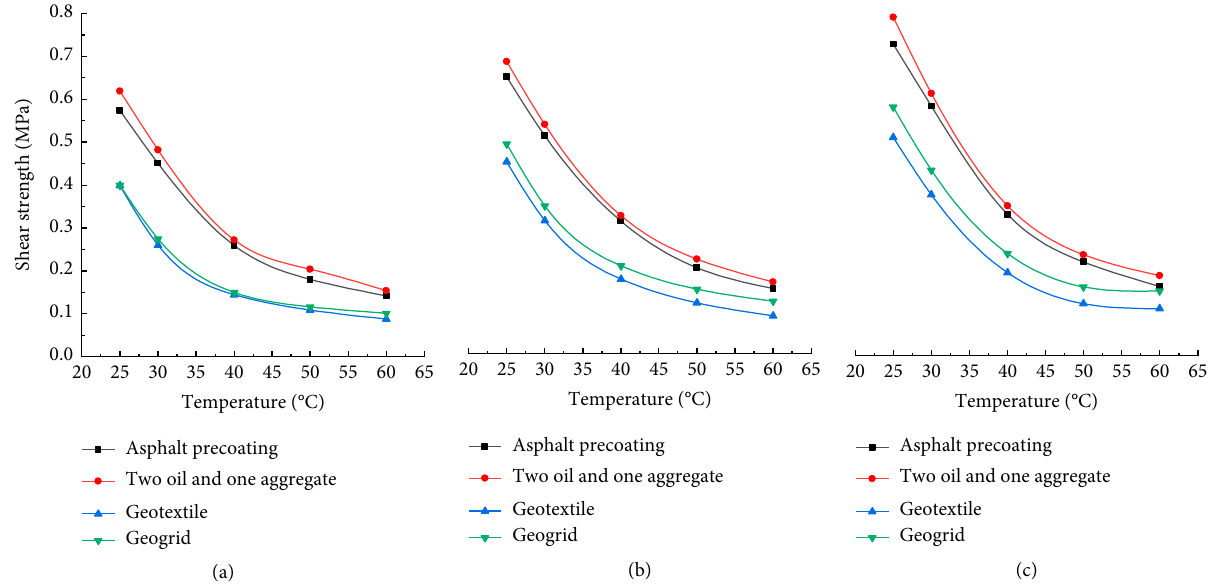
Figure 17: Comparison of shear resistance between different materials and different layers: (a) ordinary hot asphalt, (b) SBS-modified asphalt, (c) SBS-modified emulsified